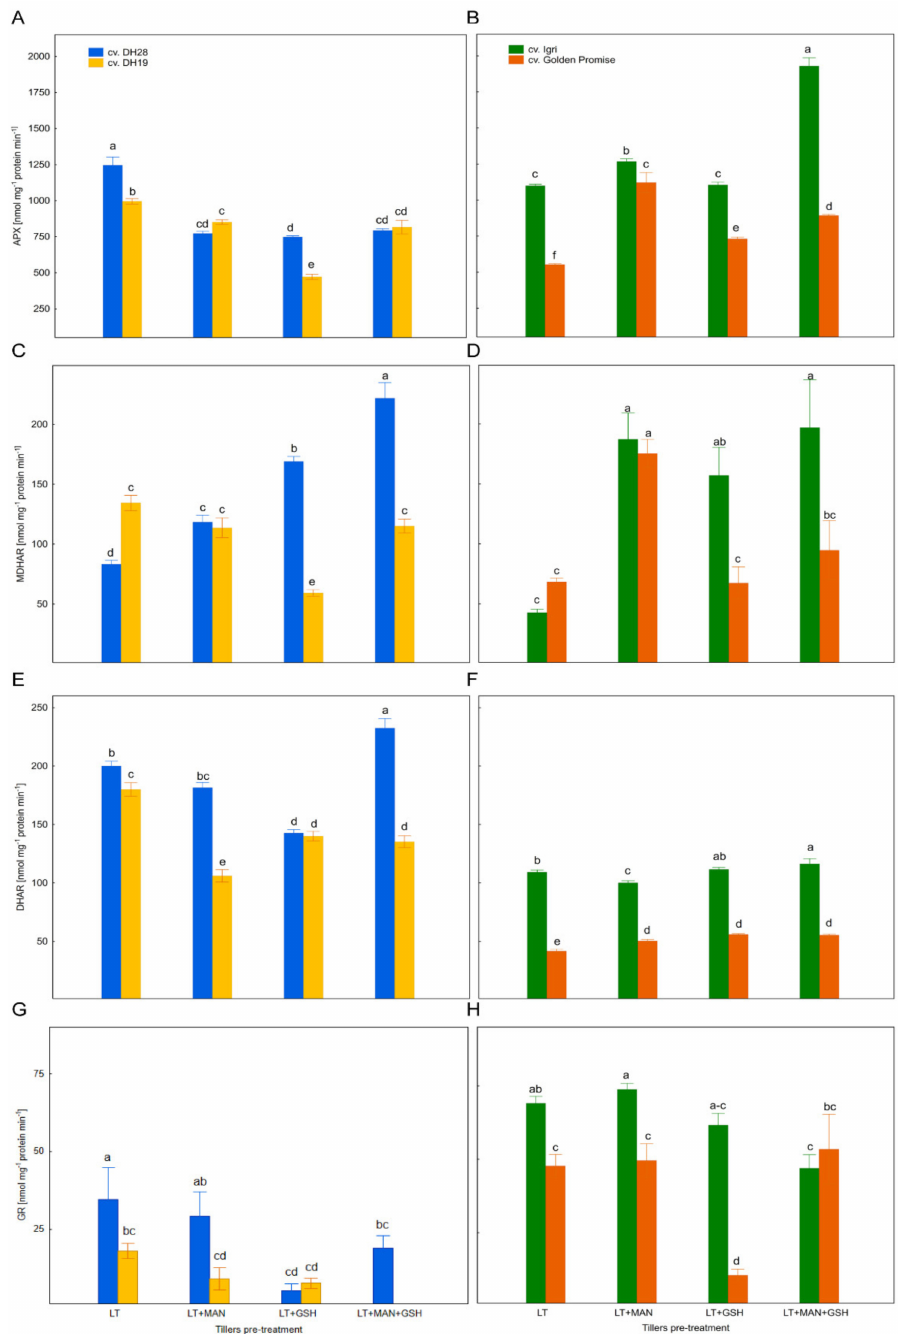
Figure 4. Activity of enzymes of the ascorbate–glutathione cycle: ( A , B ) ascorbate peroxidase (APX), ( C , D ) monodehydroascorbate reductase (MDHAR), ( E , F ) dehydroascorbate reductase (DHAR), ( G , H ) glutathione reductase (GR) in microspores of two DH triticale lines (responsive DH28 and recalcitrant DH19) and two barley cultivars (responsive cv. Igri and recalcitrant cv. Golden Promise) isolated after various tiller pre-treatments. Data represent means of three biological replications ± SE. Values marked with the same letter do not differ significantly according to Duncan’s multiple range test ( p ≤ 0.05). Please see Figure 3, LT—low temperature tiller pre-treatment (21 days at 4 ◦ C); LT + MAN—low temperature tiller pre-treatment combined with the application of 0.3 M mannitol; LT + GSH—low temperature tillers pre-treatment combined with the application of 0.3 mM reduced glutathione; LT + MAN + GSH—low temperature tillers pre-treatment combined with the application of 0.3 M mannitol and 0.3 mM reduced